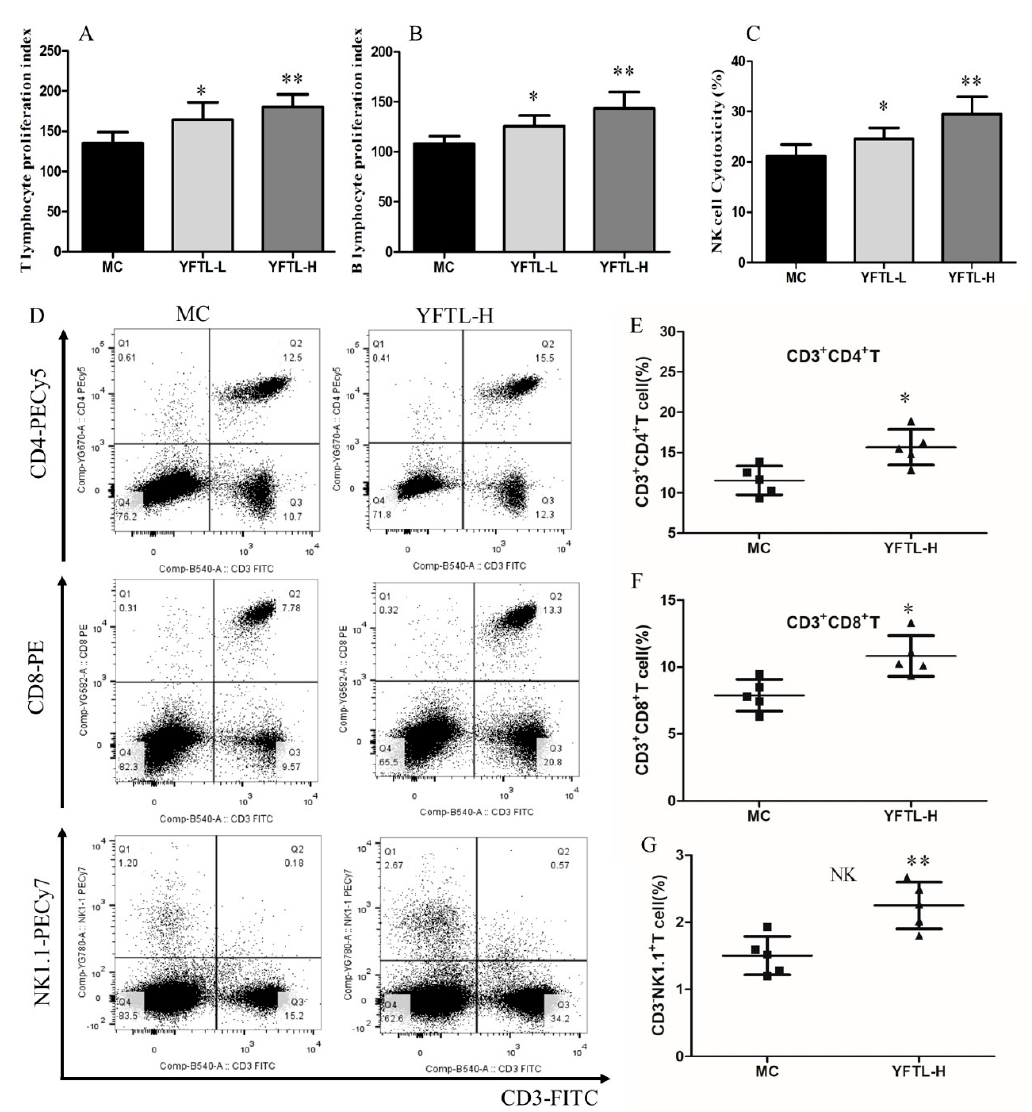
Figure 5. Effect of YFTL on splenocytes proliferation, NK cell activity and splenic lymphocyte subsets in Lewis tumor mice. ( A ) Splenocyte proliferation induced by Con A; ( B ) splenocyte proliferation induced by LPS; ( C ) splenic NK cytotoxicity; ( D ) splenic lymphocyte subsets detected by flow cytometry; ( E ) splenic lymphocyte subsets detected by flow cytometry; ( F ) CD4 + T cell, CD8 + T cell, and NK cell subsets analyzed by flow cytometry. Data are expressed as the mean ± SD, * p < 0.05, and ** p < 0.01 vs. the MC